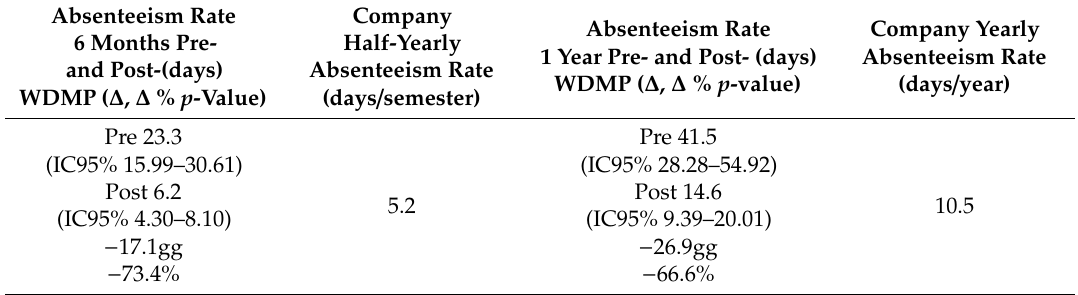
Table 3. Comparison of absenteeism rates at six months and one year before and after WDMP, as well as company